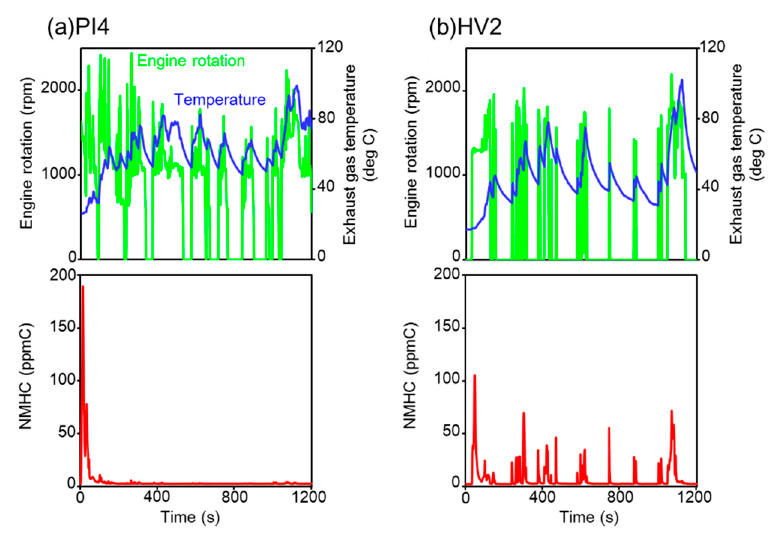
Figure 5. Relationship between fuel consumption and VOC emissions from vehicles PI-4 ( a ) and HV2 ( b ) following a cold start.